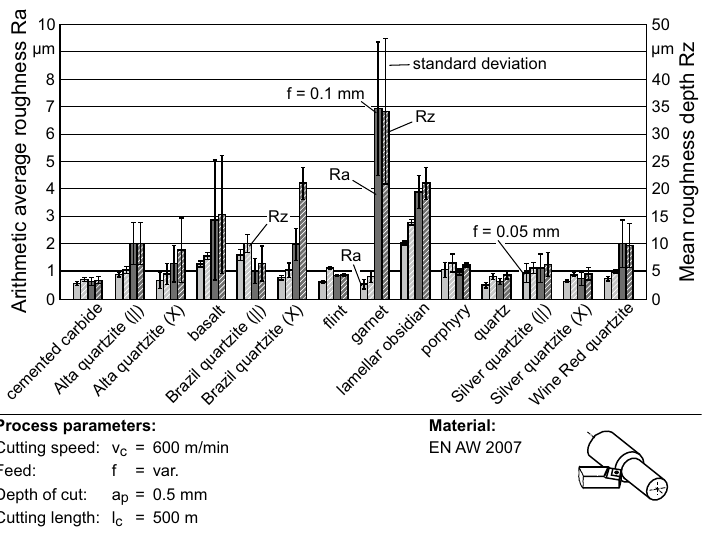
Fig. 20 Surface roughness of the workpiece after the turning